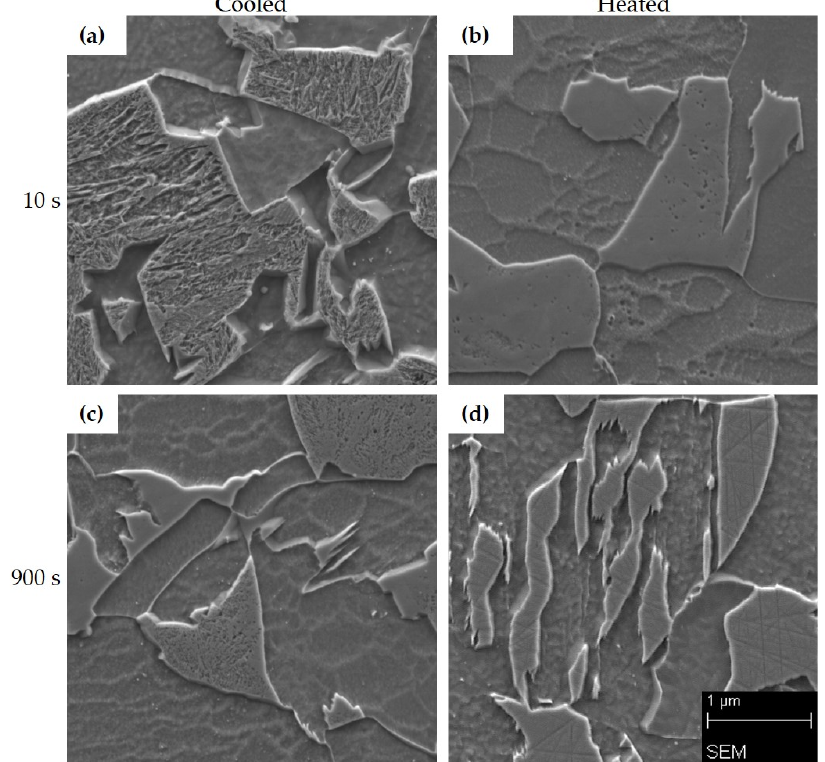
Figure 11. Microstructures of 20MnAl after hot stamping under a scanning electron microscope: ( a ) 10s_C, ( b ) 10s_H, ( c ) 900s_C, ( d ) 900s_H.